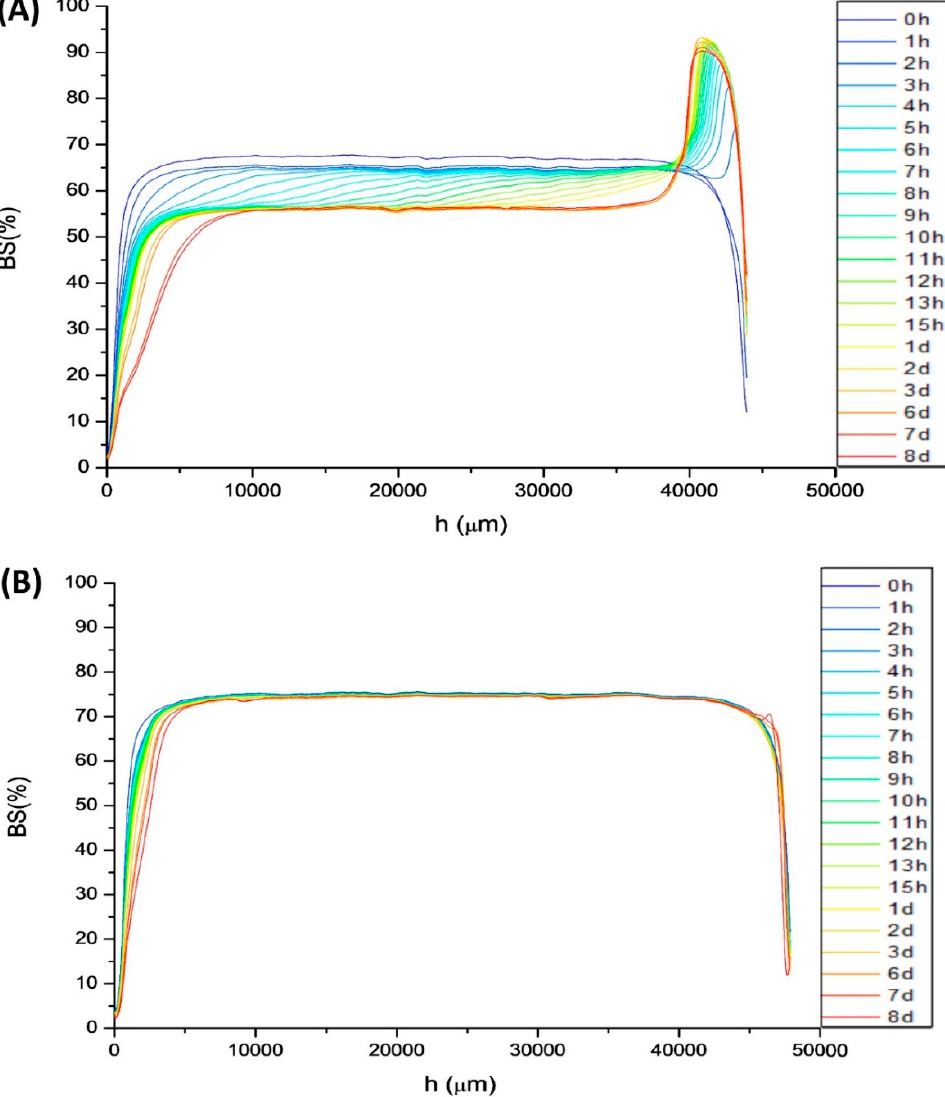
Figure 6. Backscattering values versus measuring cell height with aging time for ( A ) the 100 / 0 system and ( B ) the 75 / 25 system.